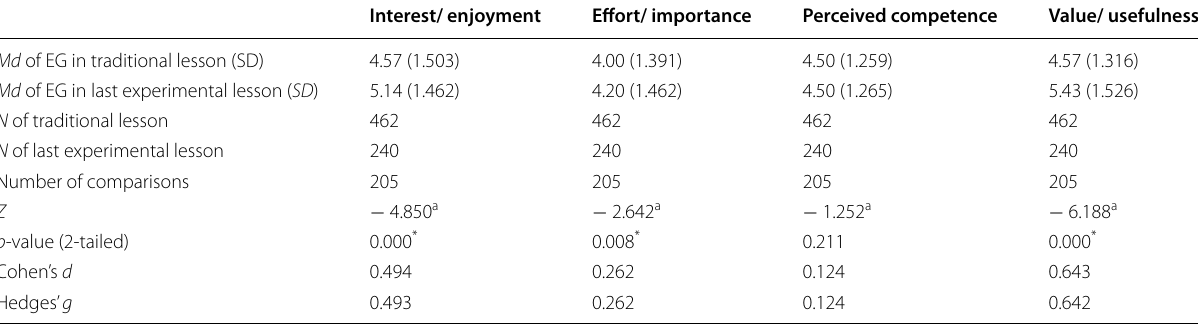
Table 5 Change in the students’ intrinsic motivation in the EG between the control lesson (Post-Questionnaire 1) and the last experimental lesson (Post-Questionnaire 2_2) (Wilcoxon signed-rank